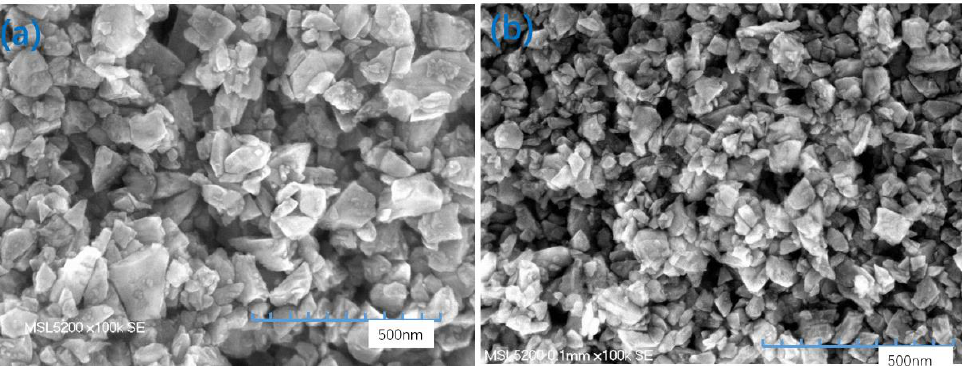
Figure 14. SEM images of slurries with diamonds of different sizes: ( a ) normal size (118 nm); ( b ) ultrafine slurry (100 nm).